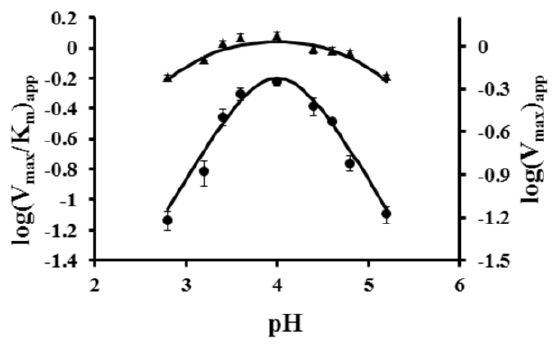
Figure 4. The effect of pH on the affinity of recombinant N CsOxOx D241A for oxalate. pH dependence of CsOxOx D241A ) and V max ( m ) for the CsOxOx mutant on kinetic parameters V max /K m ( catalyzed reaction. doi:10.1371/journal.pone.0057933.g004 Figure 5. CD spectra of recombinant, wild-type CsOxOx and the putative active site mutants. All samples were 938 ug/mL in phosphate buffer (pH 7.0): wild-type CsOxOx, black; D241A, dark blue; D241S, grey; A242E, orange; DASN241-244SENS, red; R169K, cyan; R349K, yellow.